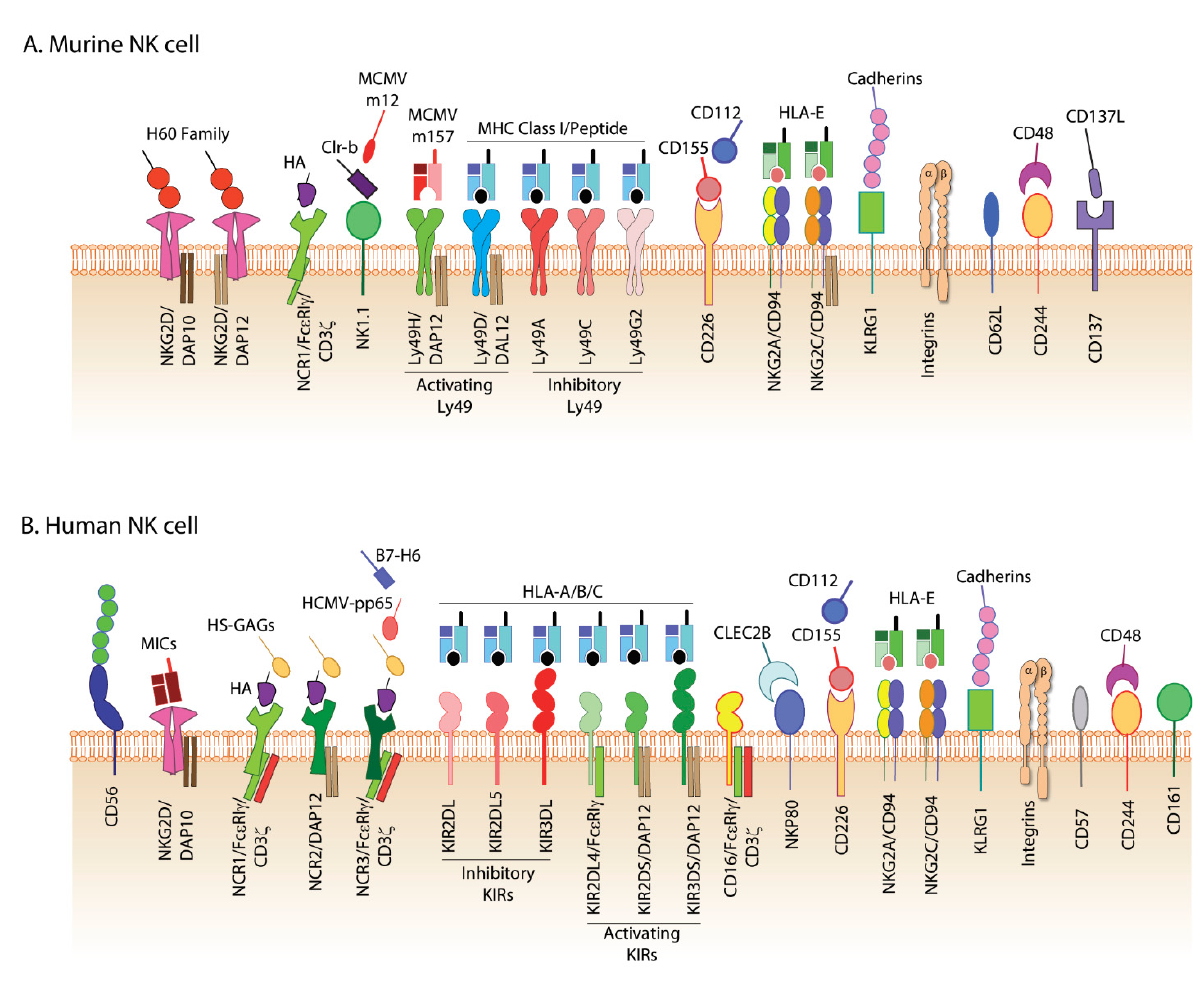
Figure 2. Major cell surface receptors expressed in ( A ) murine and ( B ) human NK cells. NK cells express activating receptors, inhibitory receptors, integrins, and others. HA, influenza virus-derived hemagglutinin; MCMV, murine cytomegalovirus; MHC, major histocompatibility complex; MICs. Major histocompatibility-related chains (MIC-A/B); HS-GAGs, Heparan sulfate glucosaminoglycans.